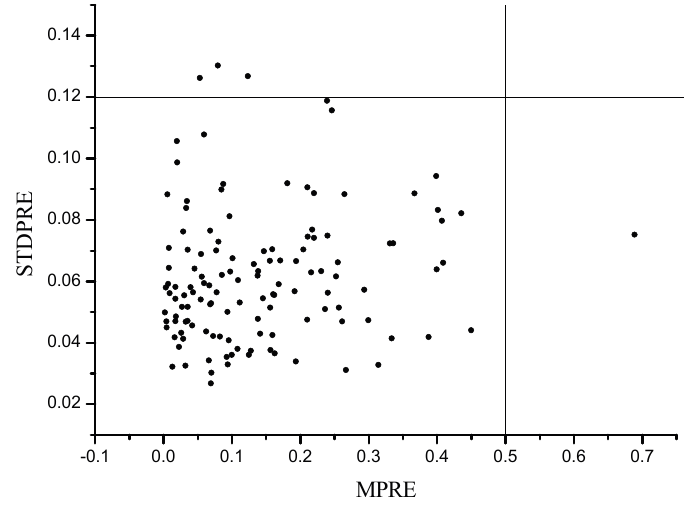
Figure 3. Scatter plot of MPRE and STDPRE of MCPLS.